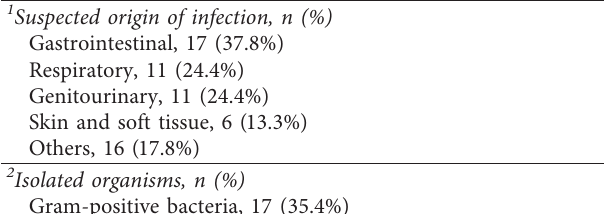
Table 6: Microbiological findings in sepsis